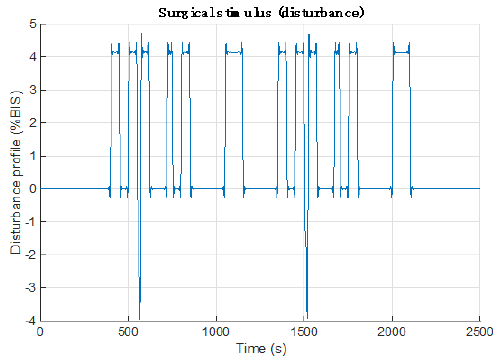
Figure 2. The nociceptor stimuli model as used in this